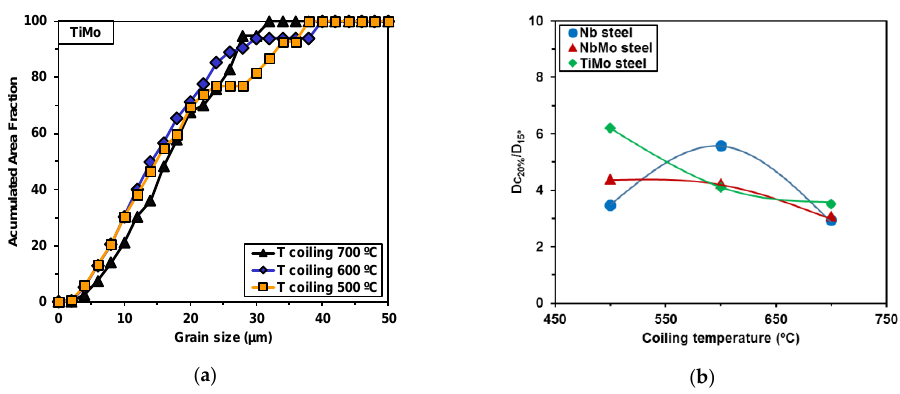
Figure 4. ( a ) Accumulated area fraction using a 15° misorientation criterion for the TiMo steel; and ( b ) evolution of the Dc 20% /D 15° parameter as a function of the coiling temperature.